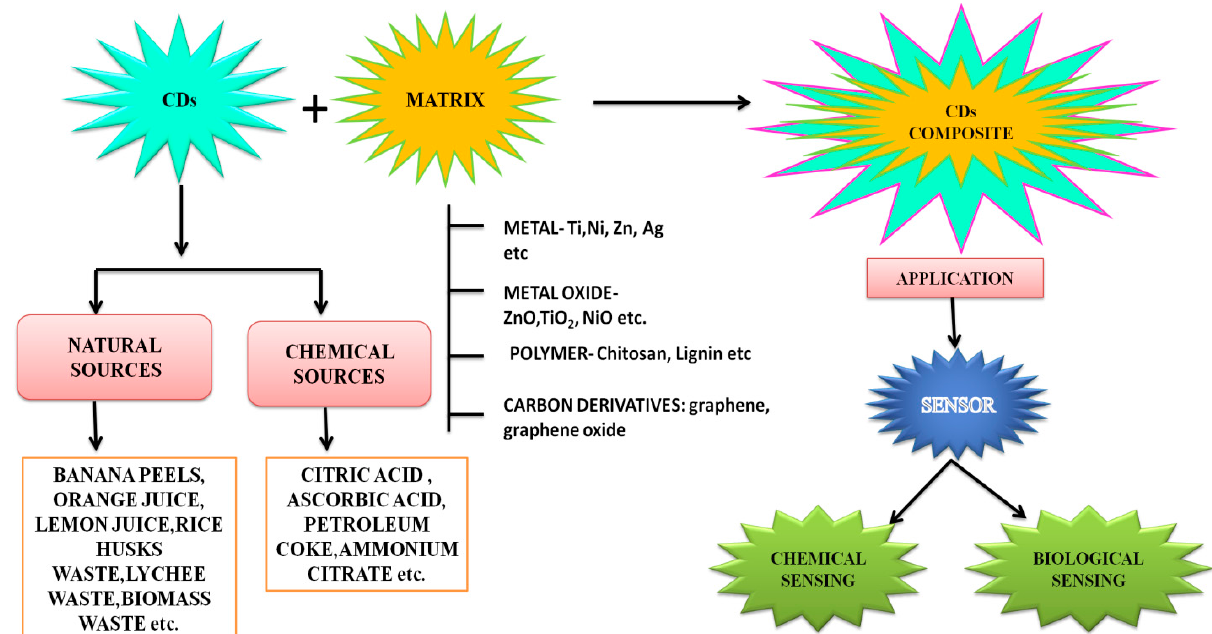
Figure 10. Overview of the synthesis of CD composites from various sources.